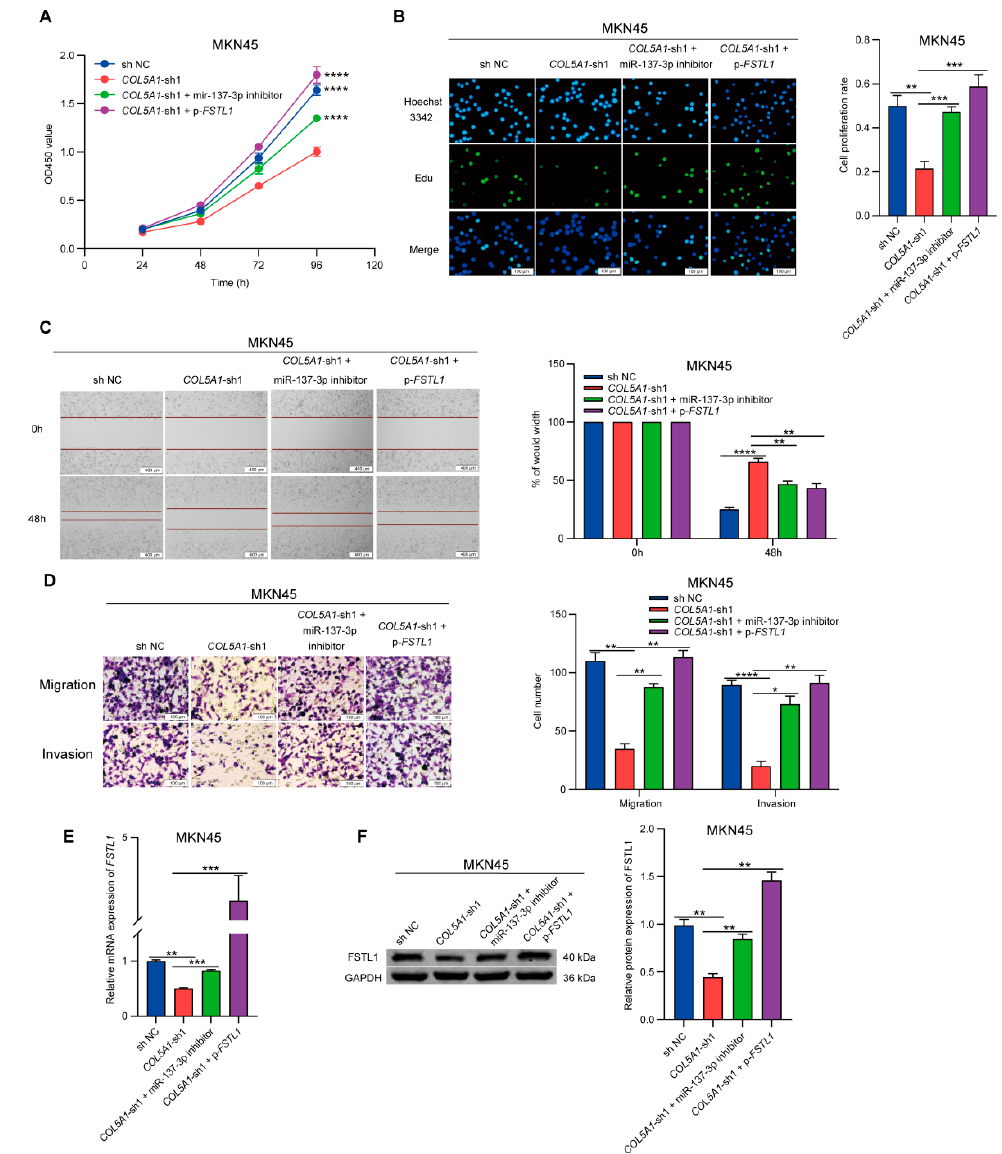
Figure 5. Overexpression of miR-137-3p inhibitor or FSTL1 rescued the loss of function caused by COL5A1 knockdown. CCK-8 assays ( A ) and EdU assays ( B ) were conducted to evaluate cell proliferation ability. Wound healing assays ( C ) and Transwell assays ( D ) were performed to evaluate migration and invasion ability. qRT-PCR ( E ) and Western blotting ( F ) were performed to assess the expression level of FSTL1 in the 4 groups. Full uncropped figures of Western blotting can be found in Supplementary File S5. Data are presented as mean ± SD of three independent experiments. * p < 0.05; ** p < 0.01; *** p < 0.001; **** p < 0.0001.